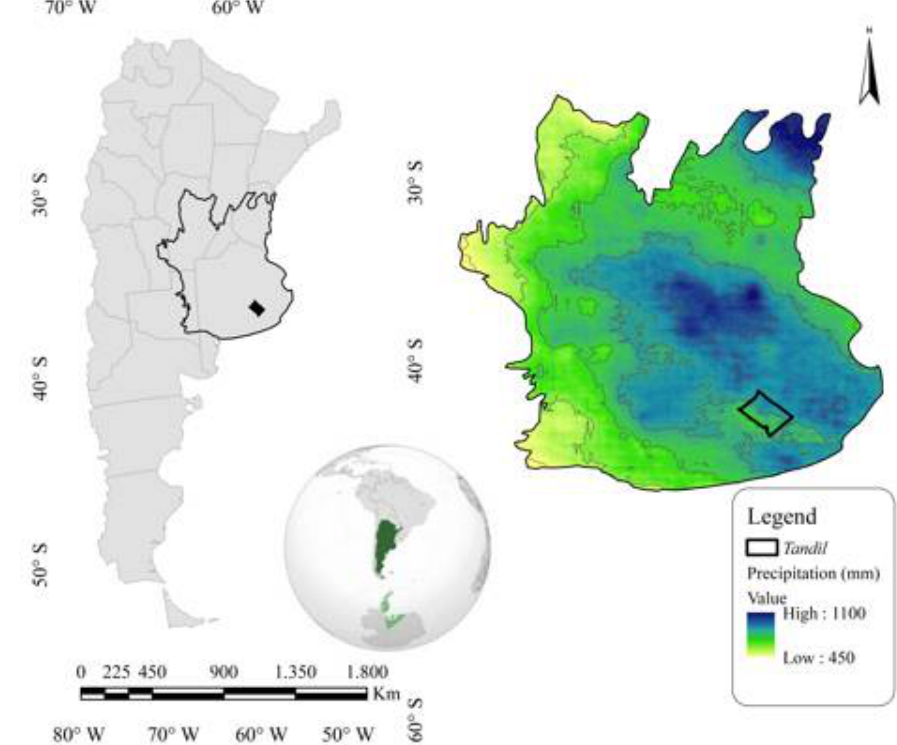
Figure 1. Location of Argentina in South America and location of Argentine Pampas (left); location of Tandil County in southeast Pampas Region and distribution of mean annual precipitation within the region (right).